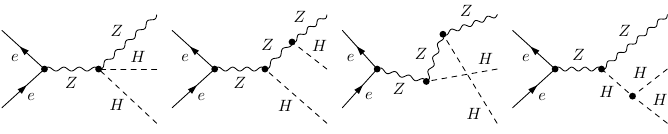
Figure 2 . The Feynman diagrams which contribute to the scattering process of e (cid:0) e + ! Z 0 HH at the tree level in the SM. The amplitude with the red dot is the only one which includes the coupling g HHH and also makes the dominant